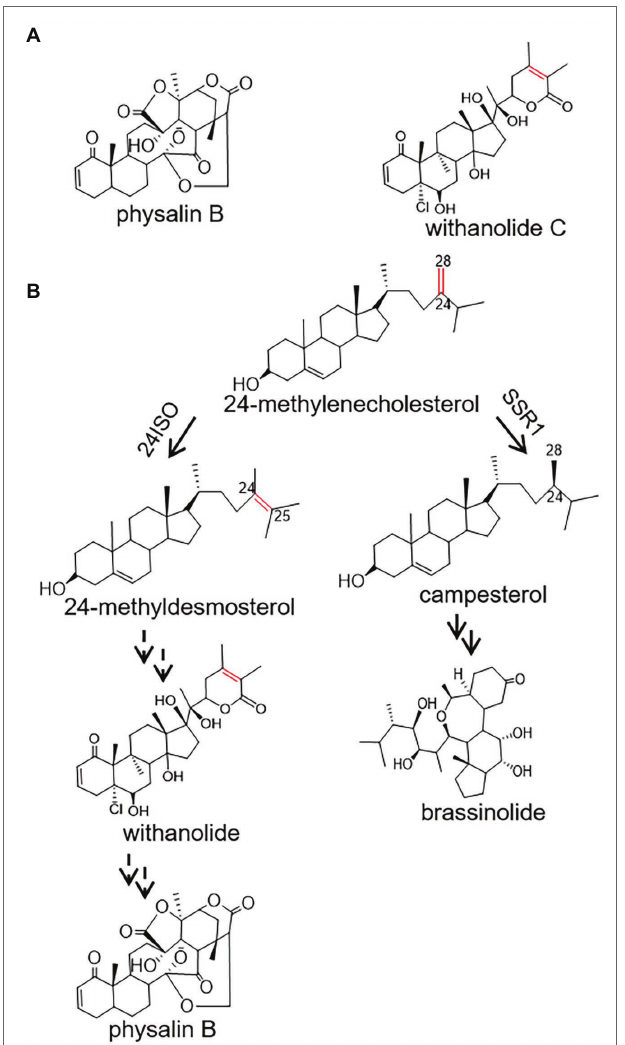
FIGURE 1 | A proposed pathway for the biosynthesis of physalin B in Physalis angulata starting from 24-methylenecholesterol. (A) The structures of withanolide C and physalin B; (B) Proposed biosynthetic routes to physalin B and brassinolide. Biosyntheses of physalin B and brassinolide diverge at the level of 24-methylenecholesterol, which is channeled to the production of physalin B through withanolide via 24-methyldesmosterol under the activity of 24ISO, or of brassinolide via campesterol, catalyzed by